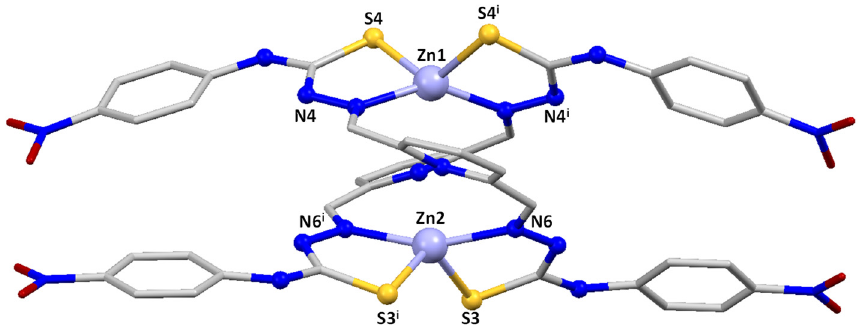
Figure 3. Crystal structure of the zinc helicate [Zn 2 (L PhNO2 ) 2 ] 3* . All three compounds are dinuclear zinc complexes with a similar helicate-type struc- ture. For that reason, a joint discussion of the three compounds will be made, highlighting in each case similarities and